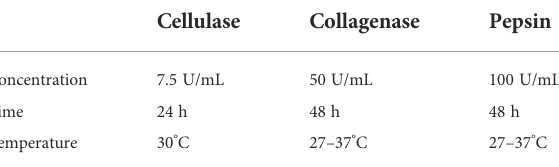
TABLE 1 Summary of the optimal conditions of enzyme treatment for A. castellanii excystment. Optimal condition is de fi ned as the enzyme treatment condition where more than 96% amoebae have excysted in the shortest period of time with the lowest enzyme